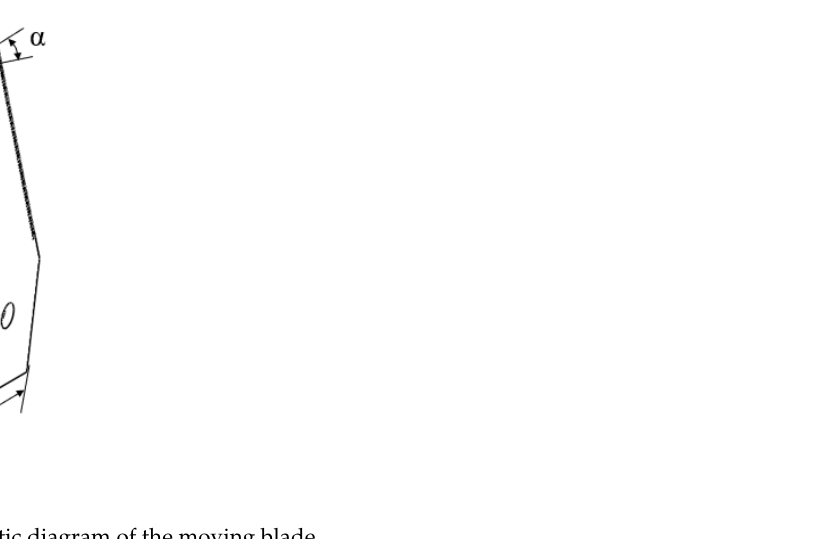
Figure 3. Schematic diagram of the moving blade. Table 1. Parameters of the moving blade.